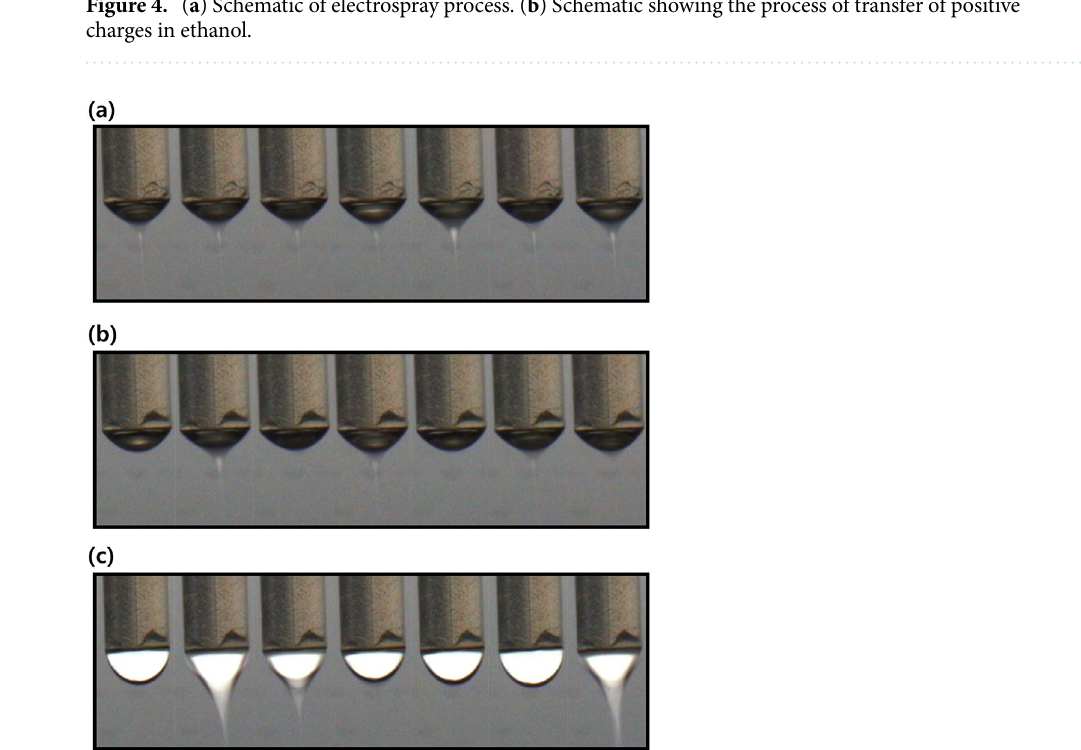
Figure 5. CCD camera snapshots of electrospray mode: ( a ) cone-jet, ( b ) pulsating, ( c )